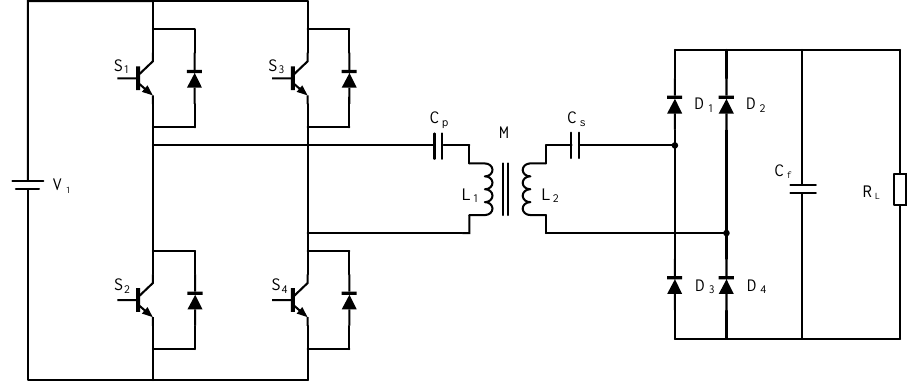
Figure 1. Circuit diagram of a wireless power transfer (WPT) system.